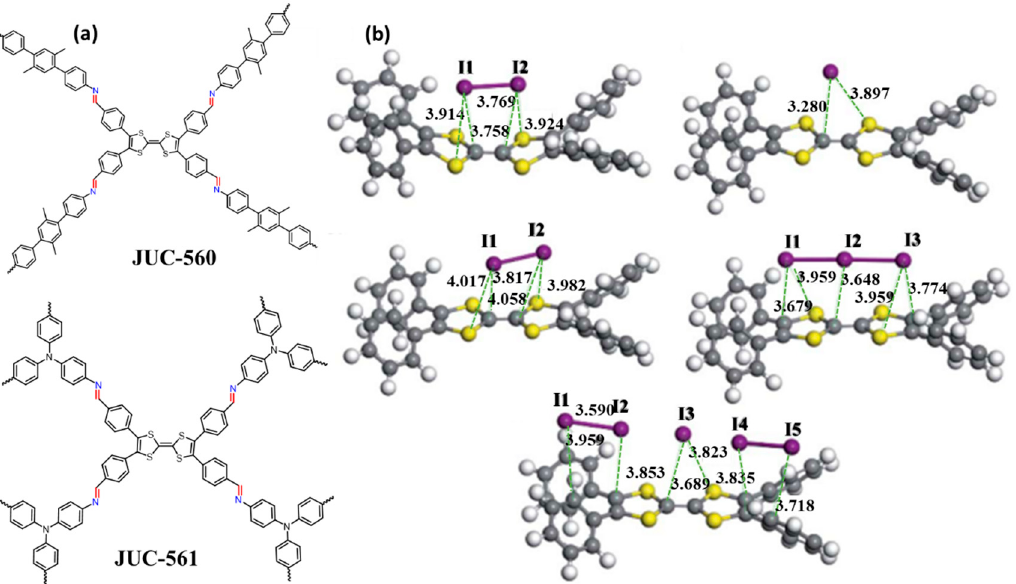
Figure 16. ( a ) Building unit of JUC-560 and JUC-561. ( b ) Optimized geometries of TTF· + and polyiodides. Reprinted/adapted with permission from Ref. [50]. Copyright (2021), Royal Society of Chemistry. Table 1. Some structural features and adsorption properties of volatile I 2 (348~350 K and 1 bar) of the reported COFs.